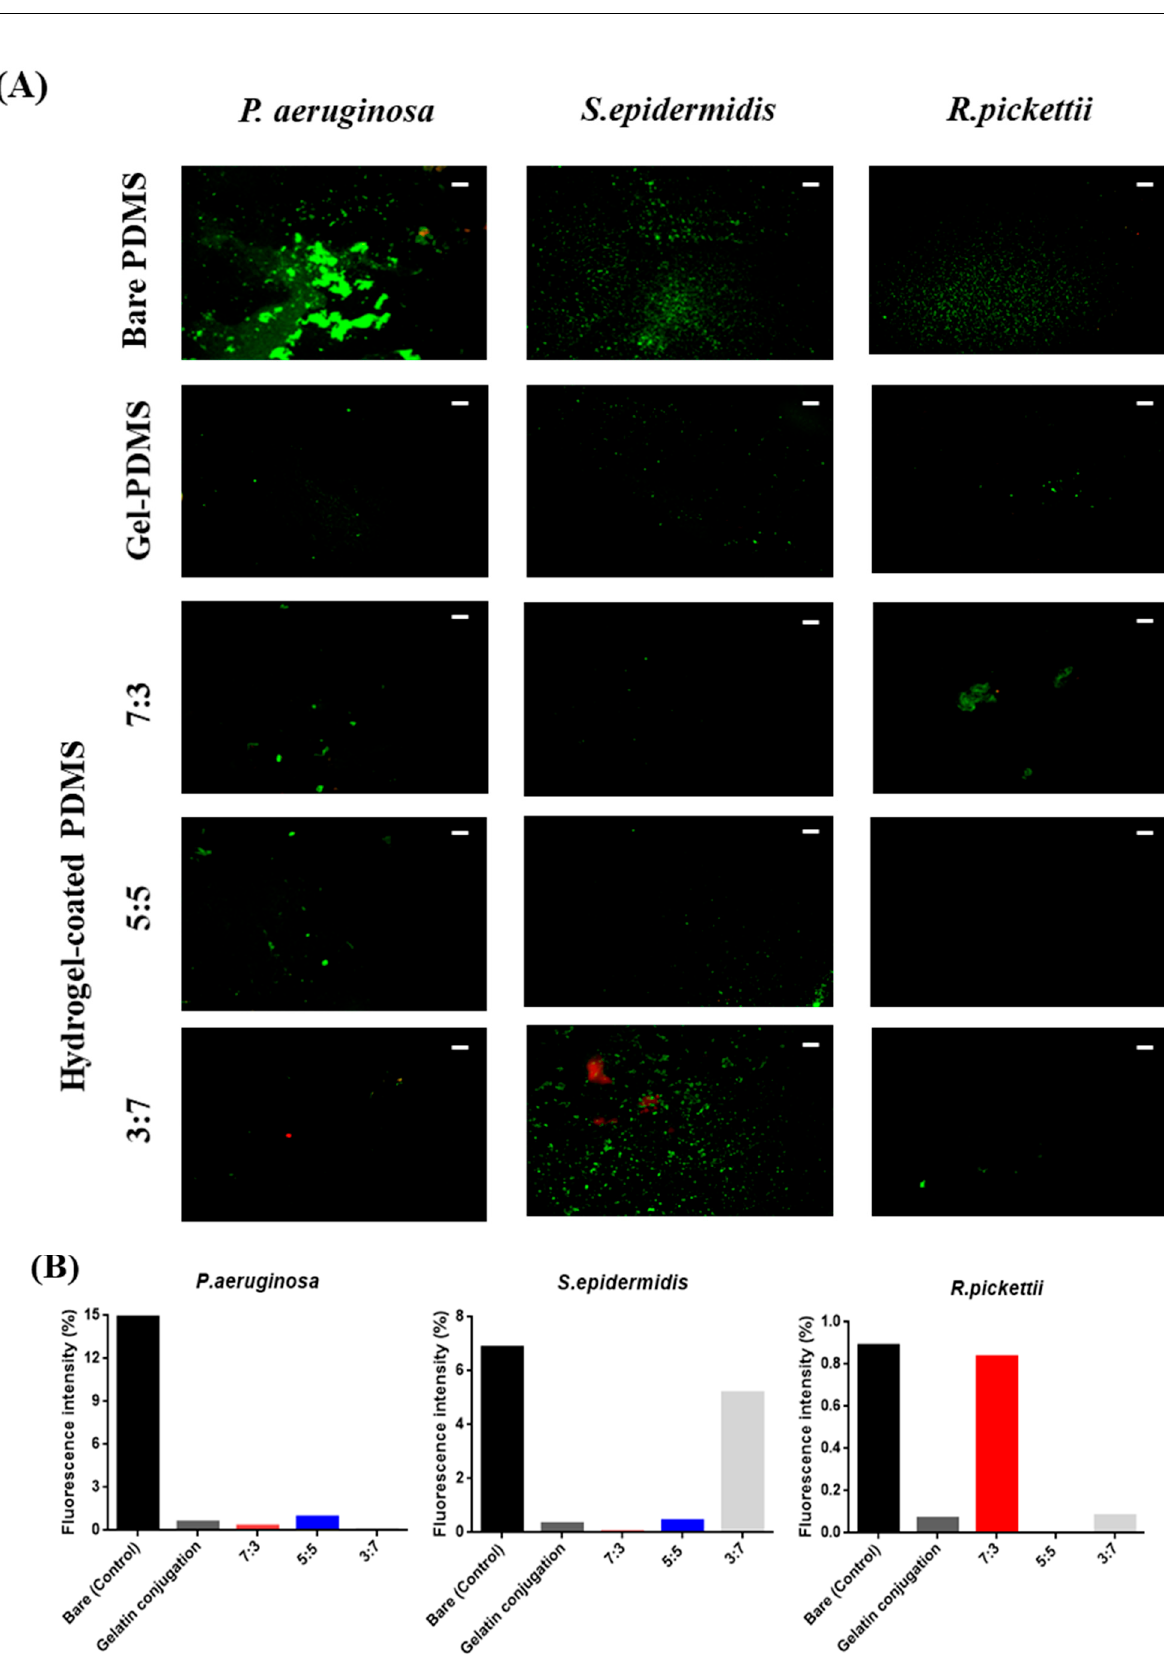
Figure 7. ( A ) Bacterial anti-adhesion effect on P. aeruginosa , S. epidermis , and R. pickettii on the surfaces of bare poly(dimethylsiloxane) PDMS and PDMS modified with gelatin and hydrogel composed of CHO–HA/Gel–NH 2 (the scale bar represents 100 µ m); ( B ) Semi-quantitative results of bacteria LIVE/DEAD images.